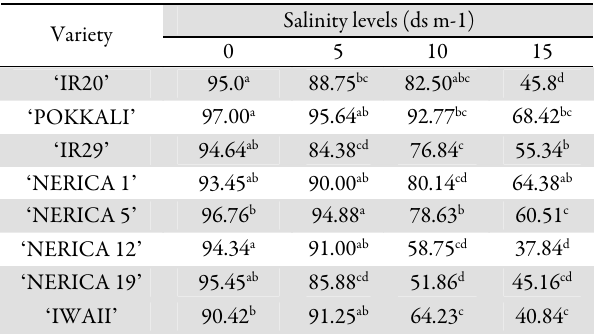
Tab. 1. Effect of Salinity on germination percentage of different rice varieties